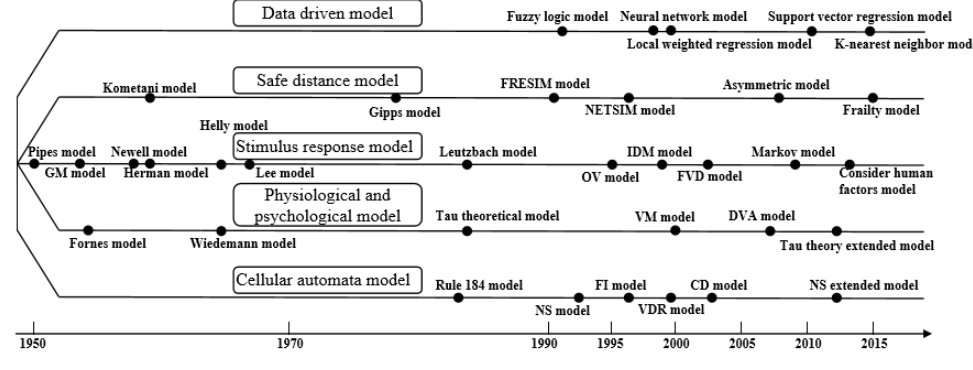
Figure 1. Development history of the car-following model [8].